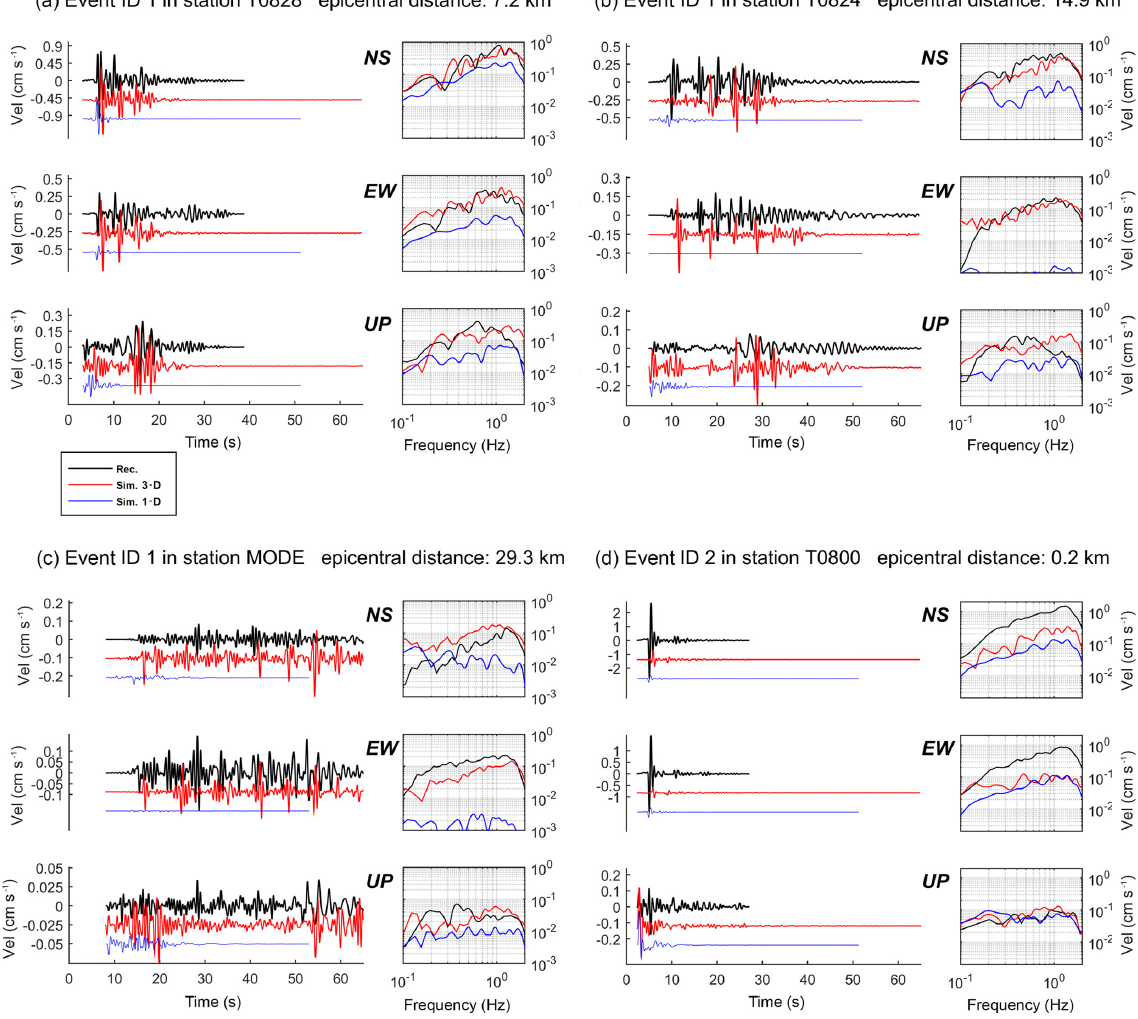
Figure 10. Comparison between recorded (in black) and predicted (in red is the 3-D model and in blue the 1-D model) ground velocity time series and Fourier amplitude spectra in four cases. (a–c) The June 2012 M W 4.1 event at three stations (T0828, T0824 and MODE), southward of the epicenter: the ground motion predicted from the 3-D model results significantly more consistent with the observations than the one predicted from the 1-D model. (d) The May 2012 M W 4.0 event in station T0800 just above the hypocenter: the underestimation of the S -wave peak and the overestimation of the P -wave peak suggest that the actual source mechanism could be different from what we assumed (see